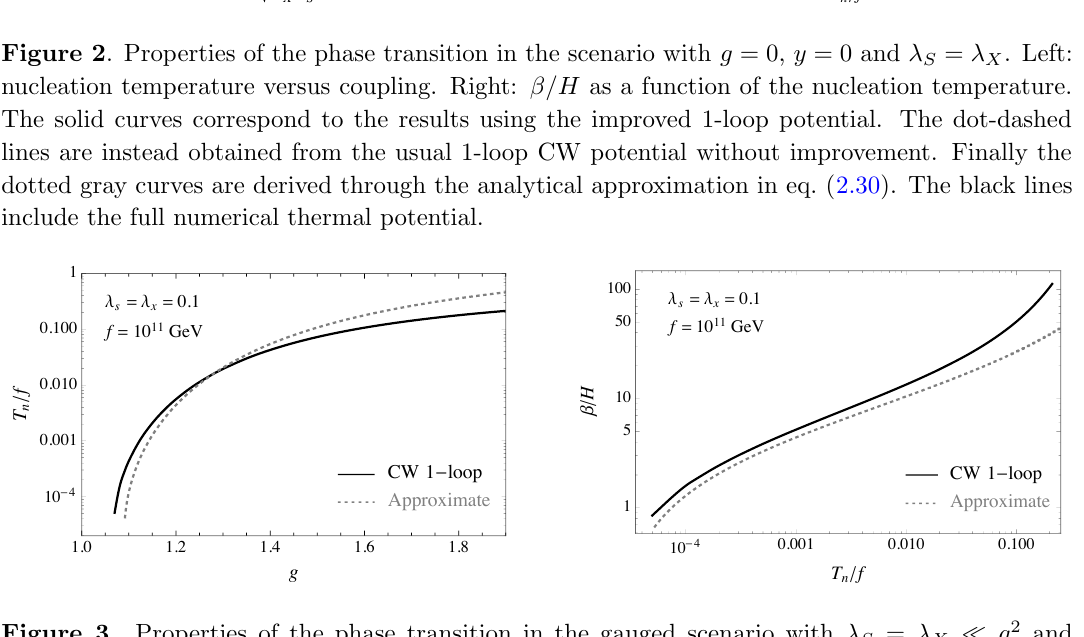
Figure 3 . Properties of the phase transition in the gauged scenario with (cid:21) S = (cid:21) X (cid:28) g 2 and y = 0. Left: nucleation temperature versus coupling. Right: (cid:12)=H as a function of the nucleation temperature. The solid curves are obtained using the 1-loop CW potential, while the dotted gray ones are derived through the approximate analytic result. The black lines include the full numerical thermal